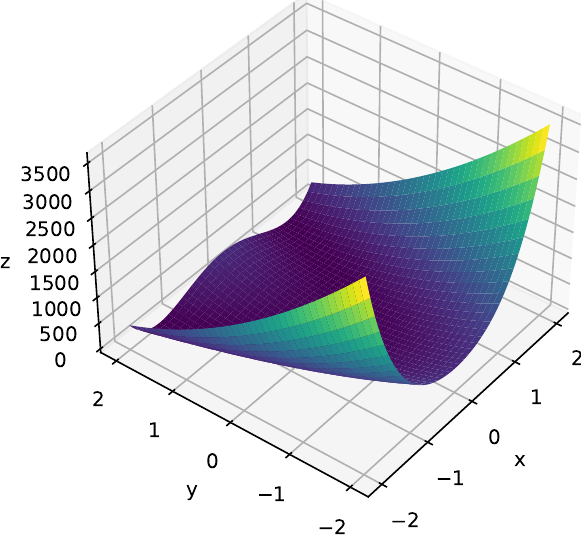
Figure 4. Illustration of the standard Rosenbrock function defined by two variables and given by f ( x , y ) = ( a − x ) 2 + b ( y − x 2 ) 2 . Here, we assume a = 1, b = 100, and the minimum value of zero is at